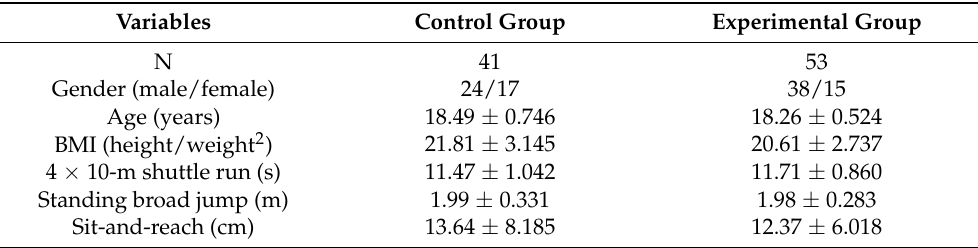
Table 1. Demographic characteristics of participants (M ± SD).